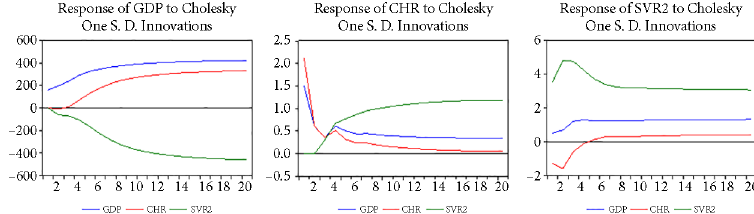
Figure 4. Response of model of Cluster C to Generalized One S.D. Innovations (source: authors ‘own